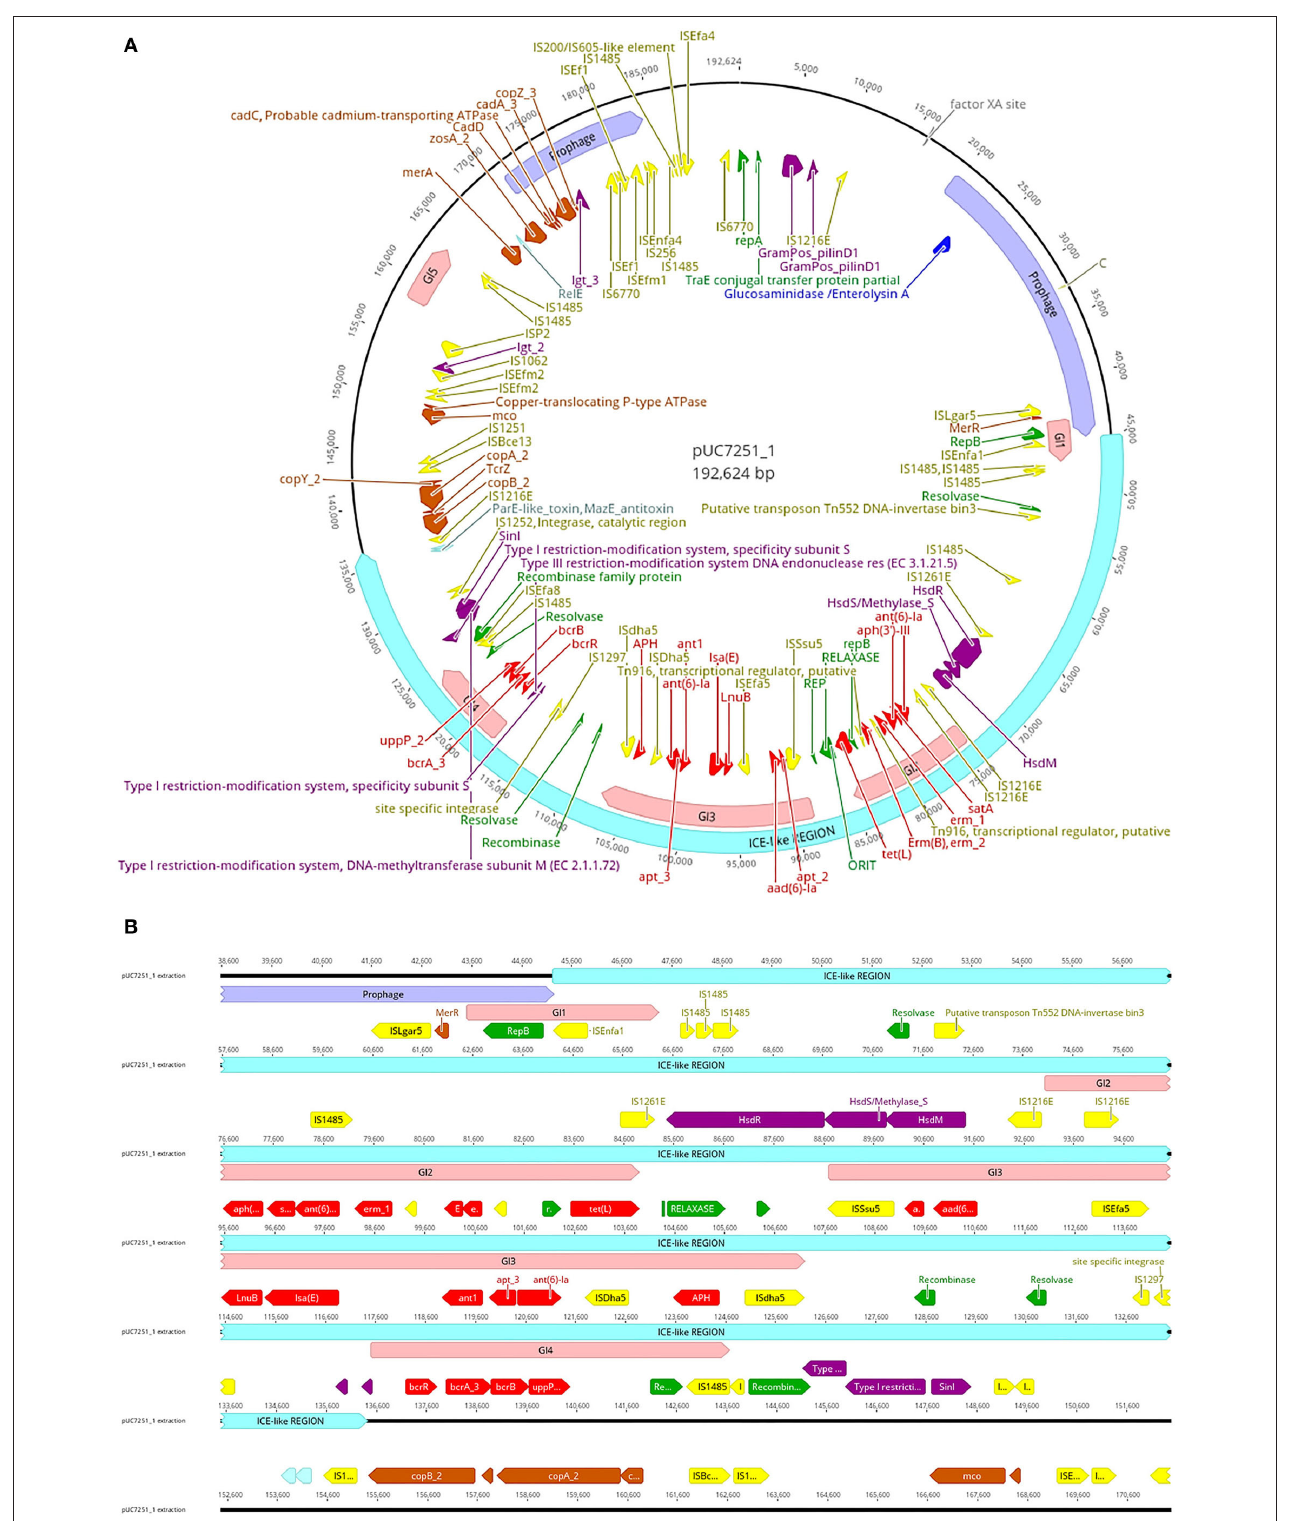
FIGURE 2 | (A) Map of plasmid pUC7251_1 harboring one large containing prophage sequences (mauve), an integrative and conjugative-like element (cyan), five genomic islands (pink), insertion sequences (yellow), antibiotic resistance genes (red), metal resistance genes (orange), virulence factors (dark violet), replication initiation systems (green), and toxin–antitoxin systems (light blue). (B) Details of the ICE-like region. The genetic elements are indicated with the color code mentioned before.